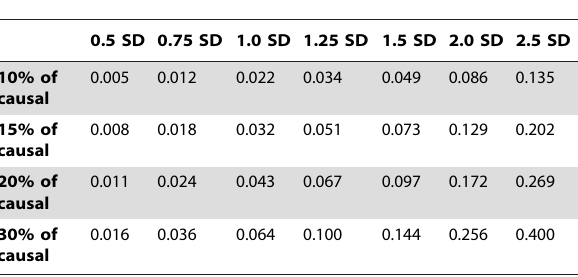
Table 4. Proportion of variance explained by rare